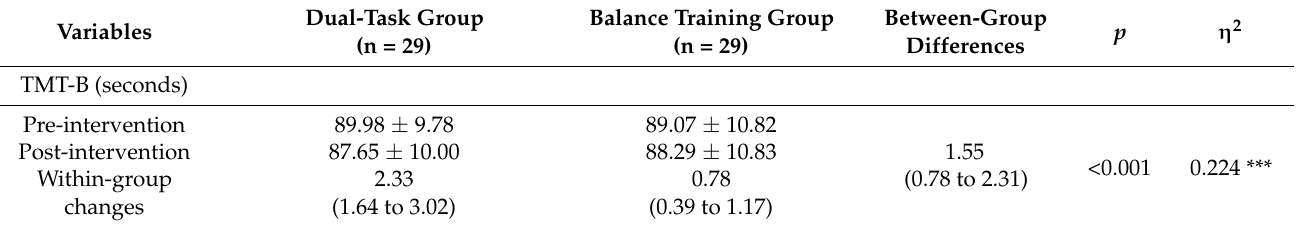
Table 5. Changes in static and dynamic balance (N =